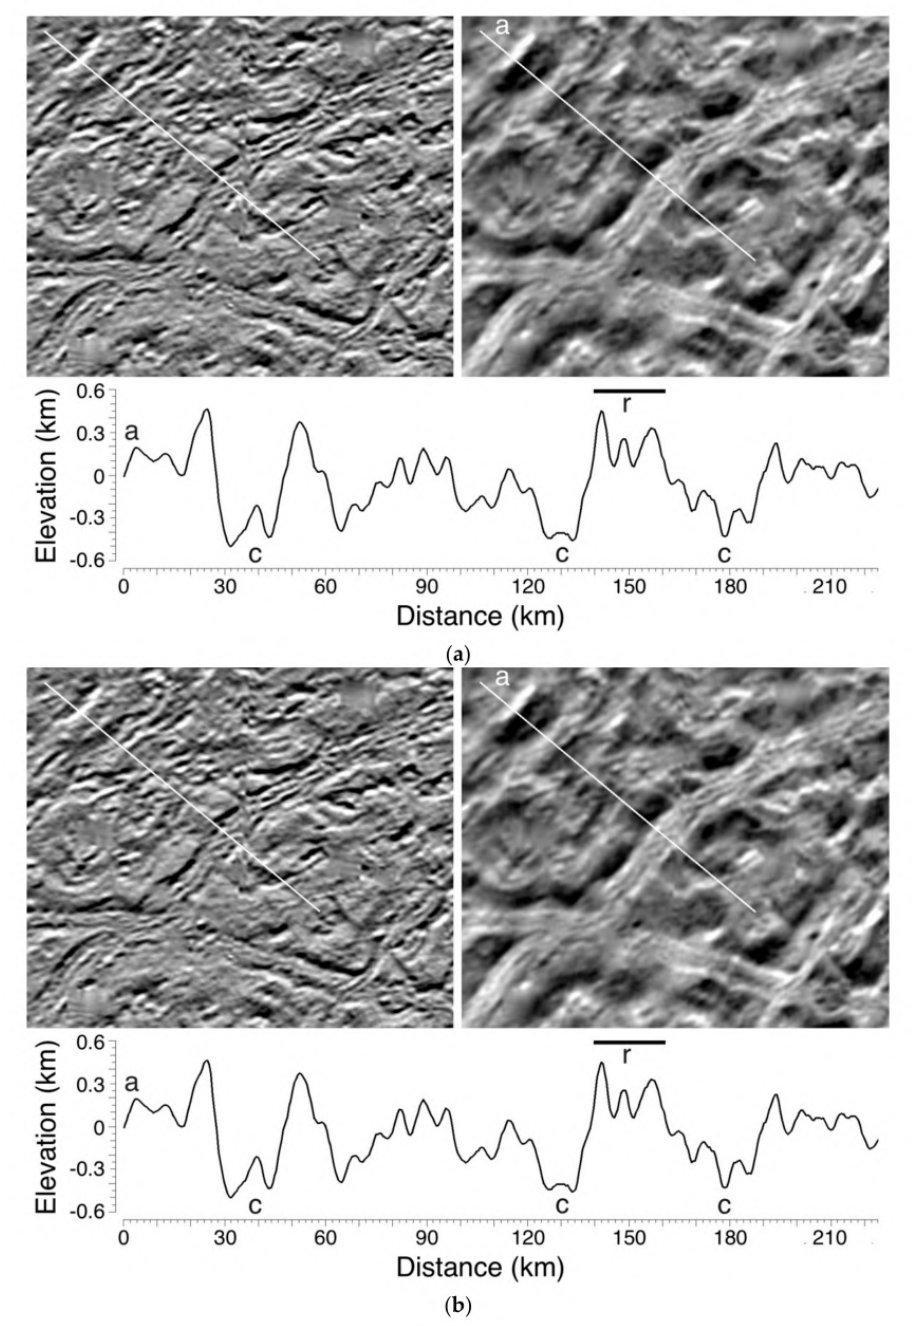
Figure 12. ( a )Topographic profile across ridge set (r) and cavi (c) within cantaloupe terrain from SG- PC-DEM in Figure 8. ( top ) Image mosaic and ( right ) DEM scene width is ~200 km. ( b ) Topographic profile across ridge set within eastern cantaloupe terrain. ( top ) Image mosaic and ( right ) DEM scene width is ~200